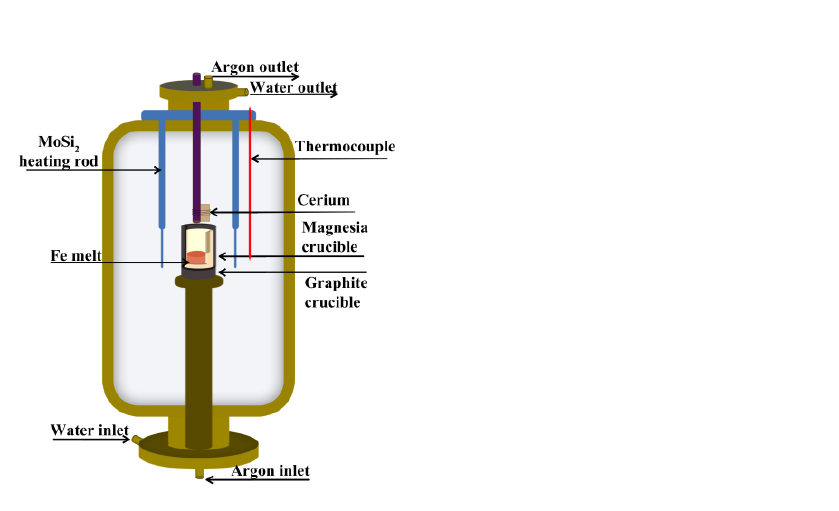
Figure 1. Schematic diagram of silicon molybdenum tube furnace.